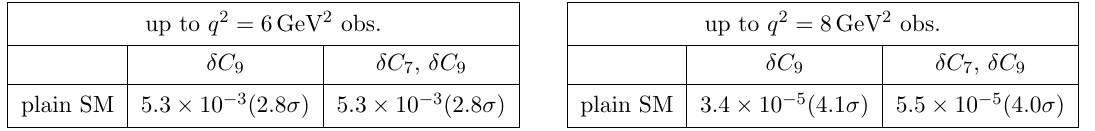
Table 5 . Likelihood ratio p -values and signi(cid:12)cances obtained through likelihood integration using observables up to q 2 = 6 GeV 2 and q 2 = 8 GeV 2 in the left and right table, respectively. up to q 2 = 8 GeV 2 obs.